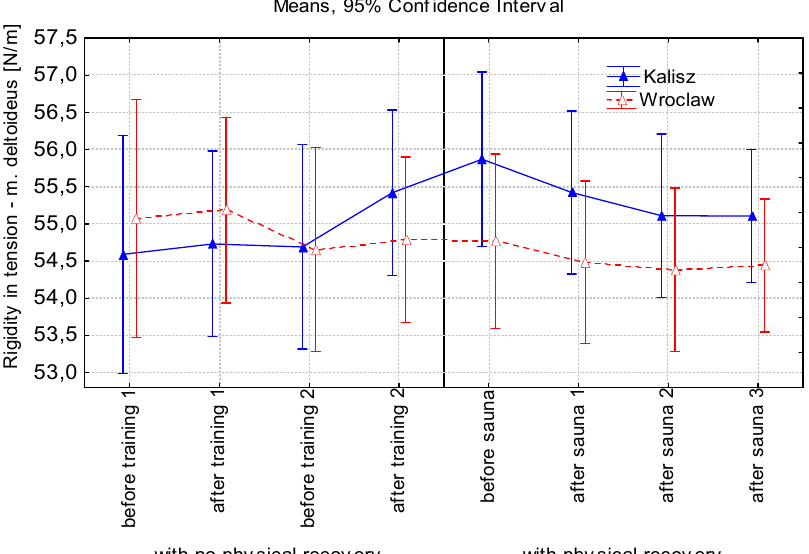
Figure 3. Stiffness differences in the deltoid muscle under tension for disabled swimmers in the training cycle without and with athletic recovery.